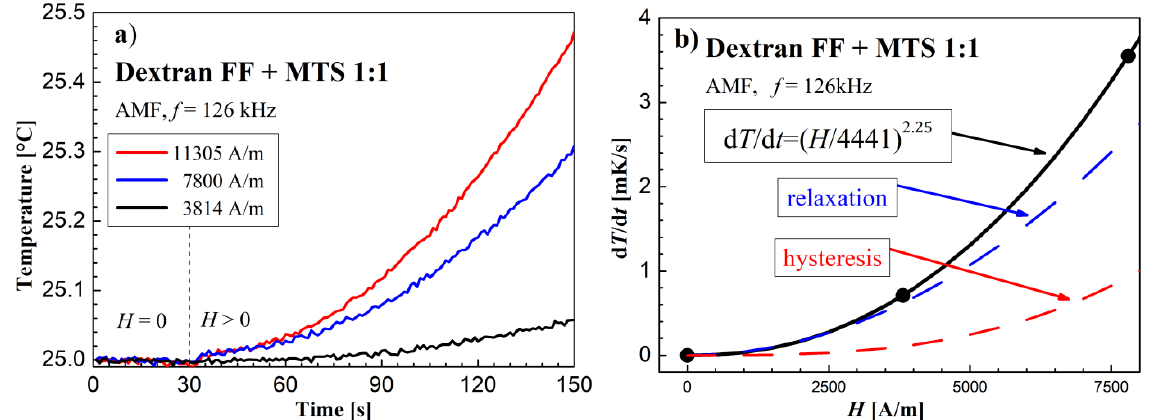
Figure 11. Time courses of temperature changes in the dextran with magnetosomes sample ( a ) and ( b ) d T /d t values depending on the amplitude of the magnetic field strength H in the AMF at the frequency f = 126 kHz.